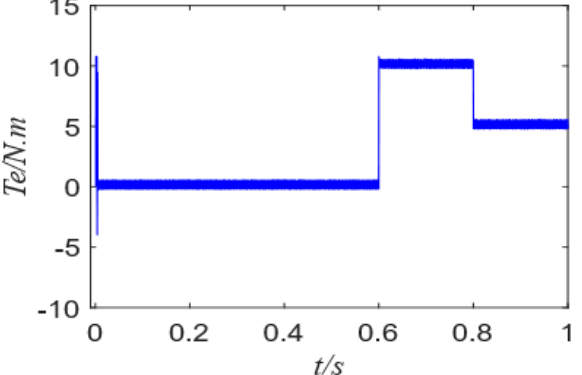
Figure 11. Torque of FCS-MPCC.